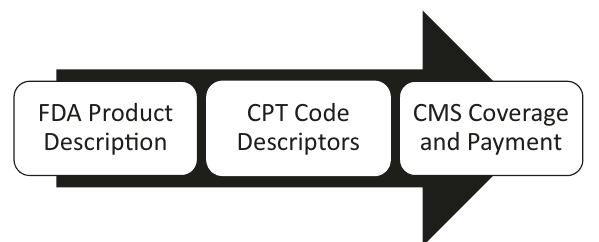
Fig. 1 The continuum of AI CPT code descriptors. Appendix S is intended to enable discrete and differentiable code descriptors by accurately characterizing the “ work done by machines ” relative to the work of the physician or other quali fi ed health care professional. Therefore, these same descriptors may be useful also in regulatory labeling of novel products like “ Software as a Medical Device ” (SaMD) and in valuation, coverage and payment policy for the associated novel services or procedures, like “ Software as a Service ” (SaaS). Table 1. The relationship between components of the service and categorization. Service